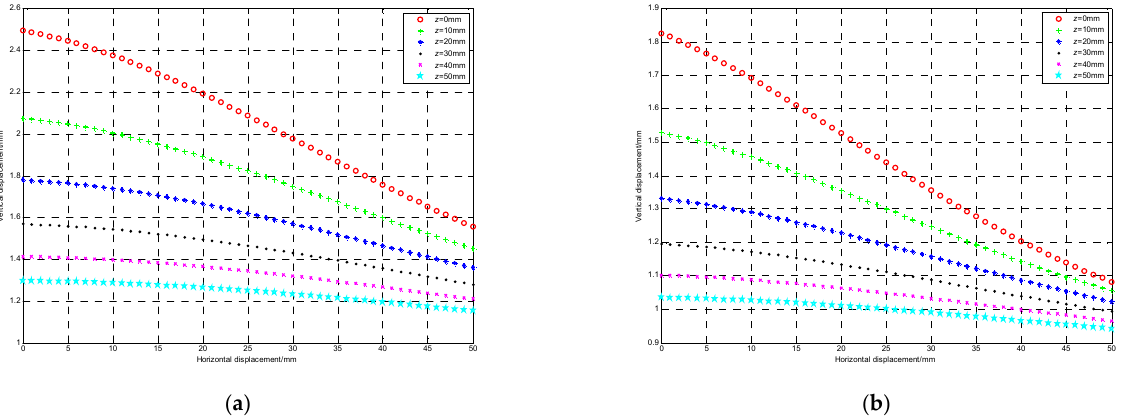
Figure 9. The relationship curve between the horizontal displacement and the double mutual inductance voltages. ( a ) Mutual inductance voltage of Type I; ( b ) mutual inductance voltage of Type II.